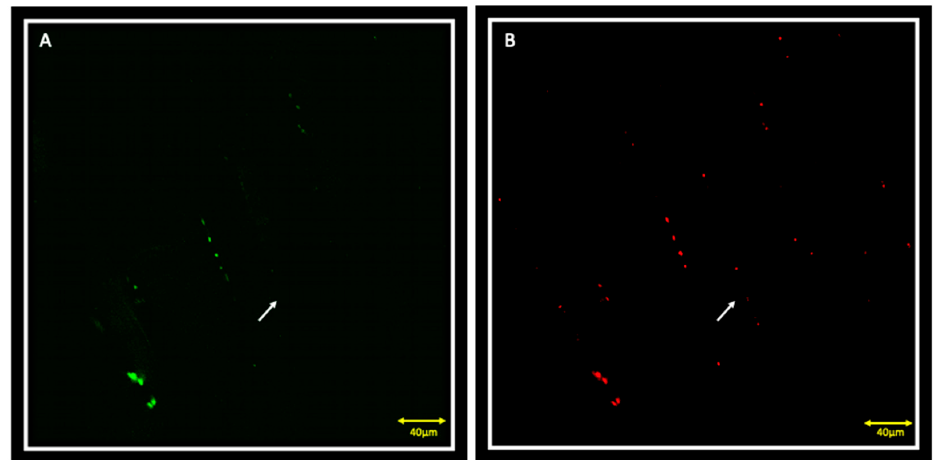
Figure 2. Splitting of channels from Figure 1 with green channel corresponding to Myf5 ( A ) and red channel corresponding to PAX7 ( B ). Results show the presence of cells that are positive for PAX7 ( B , white arrow) but negative for Myf5 ( A , white arrow).